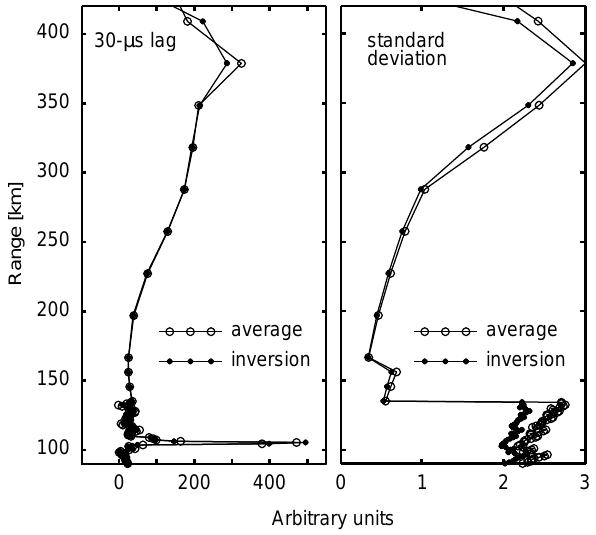
Fig. 10. Left: The 30- µ s lag profiles obtained by ordinary height integration and inversion. Right: The corresponding standard devi-